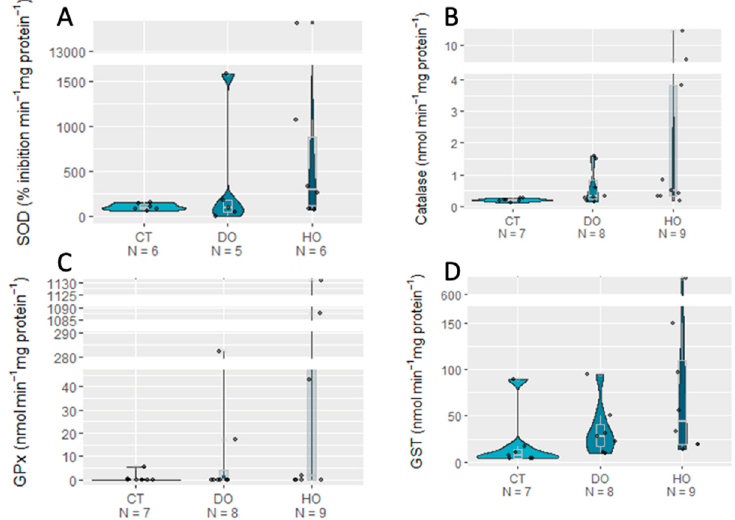
Biology 2023 , 12 , x FOR PEER REVIEW Figure 2. Antioxidant enzyme activities SOD ( A ), CAT ( B ), GPx ( C ), and GST ( D ) of S. canicula embryos exposed to experimental conditions (CT _ Control, DO _ Deoxygenation, and HO _ Hypoxia).